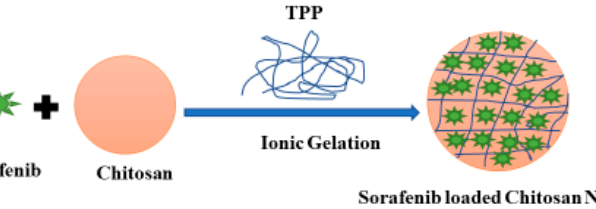
Figure 1. Schematic diagram of the synthesis steps of Sorafenib-loaded chitosan nanoparticles.